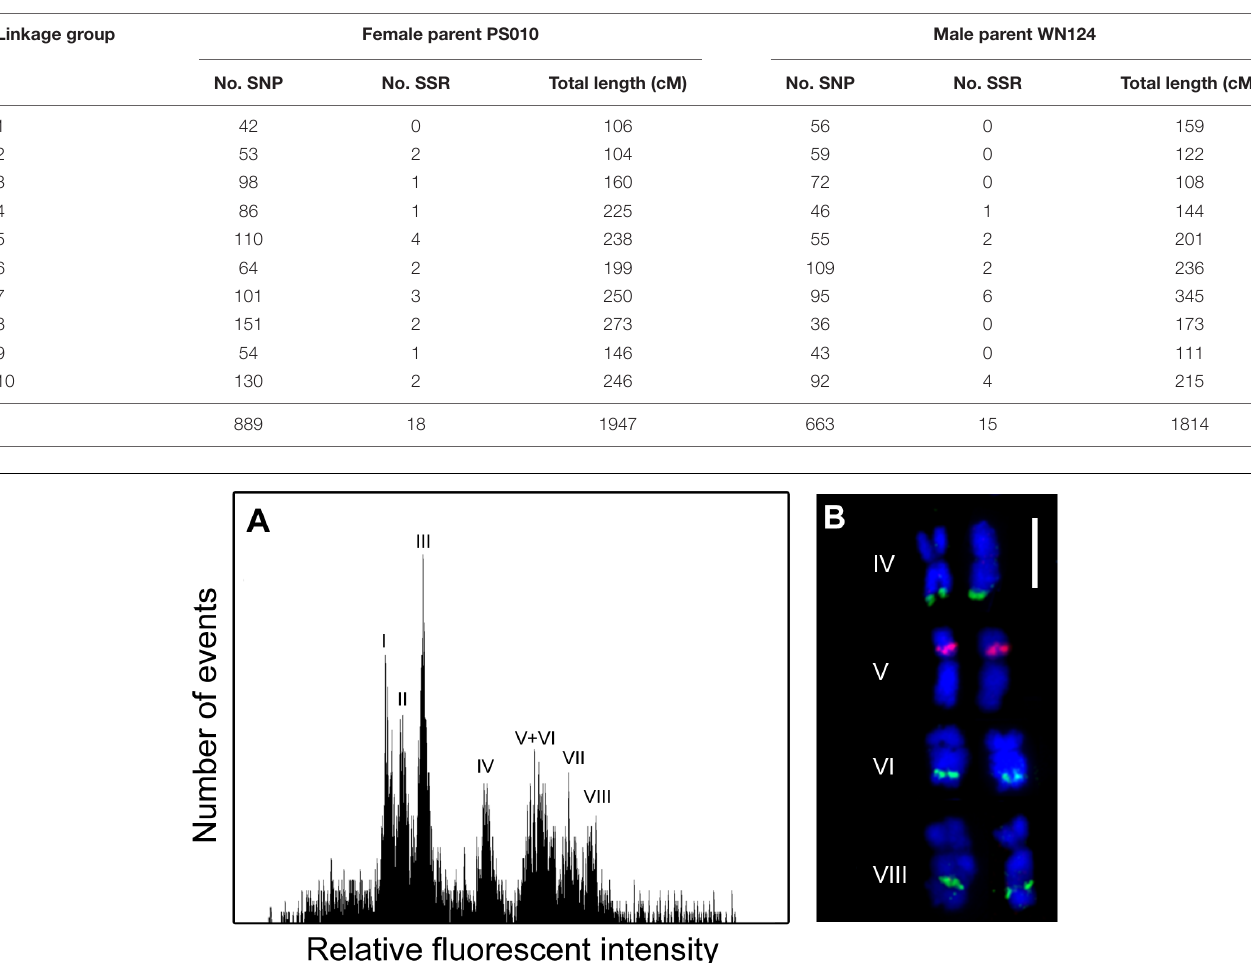
TABLE 1 | Summary of PS010 × WN124 genetic linkage maps. Linkage group